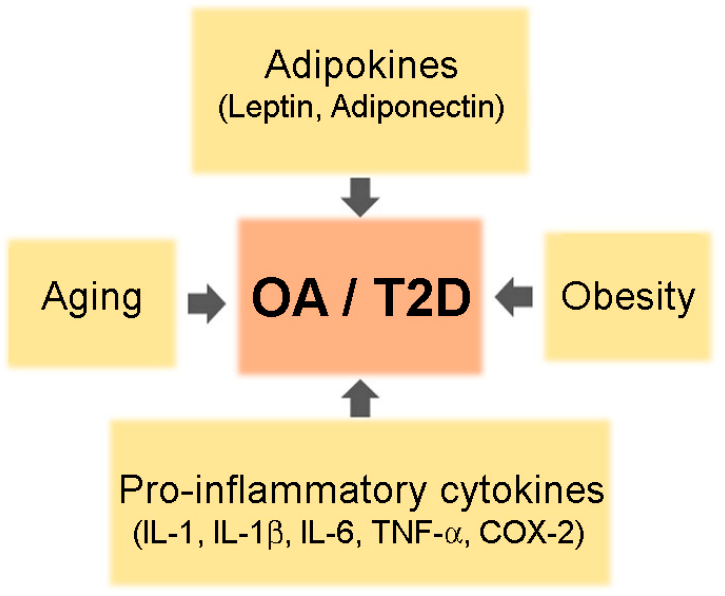
Figure 1. A schematic of common risk factors for osteoarthritis (OA) and type 2 diabetes mellitus (T2DM).